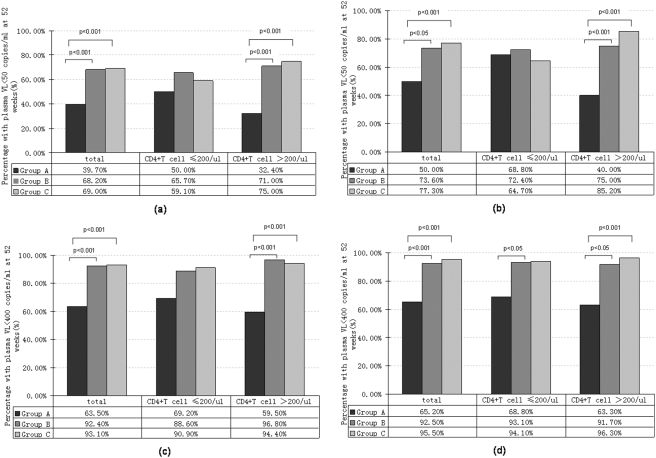
Percentage of patients with plasma VL of <50 copies/ml and <400 copies/ul at week 52.According to an analysis based on the intention-to-treat analysis (a, c) and actual tren\atment analysis (b, d). P values are calculated by pair wise comparing the viral response rate of two groups at week 52.